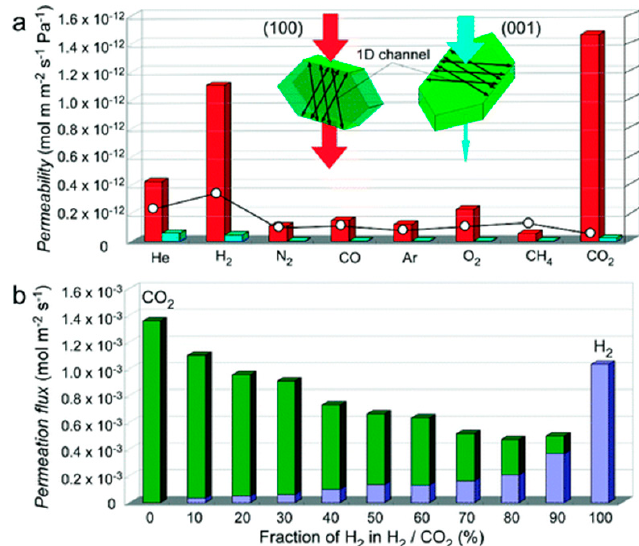
Figure 38. ( a ) Comparison of the permeabilities of crystal membrane 1 for various gases: (red) along the channels (channel membrane); (light-blue) perpendicular to the channels (nonchannel membrane). The inset plot ( ○ ) is the calculated permeability based on the Knudsen model. ( b ) Comparison of the permeation fluxes of H 2 and CO 2 along the channels of gas mixtures for various mixing ratios (H 2 , purple; CO 2 , green) (adapted with permission from ref. [135]). The [Ni 2 (L-asp) 2 (bipy)] MOF (L-asp = L-aspartic acid, and bipy = 4,4 ′ -bipyridine), a chiral MOF